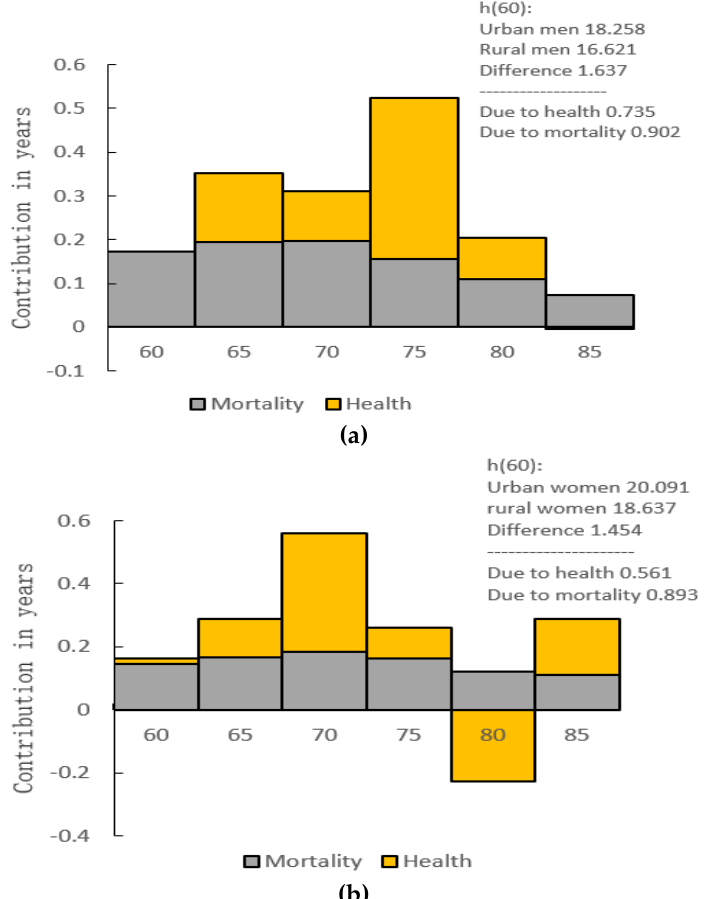
Figure 4. Decomposition of the difference between the DFLE of elderly in Jiangxi Province at age 60 between urban and rural areas. ( a ) men ( b ) women.